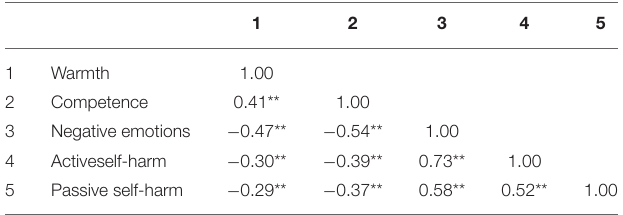
TABLE 3 | Correlations between latent variables (Model 1.0, subsample A, n = 320). And correct the variable names as follows “Active self-harm”, “Passive